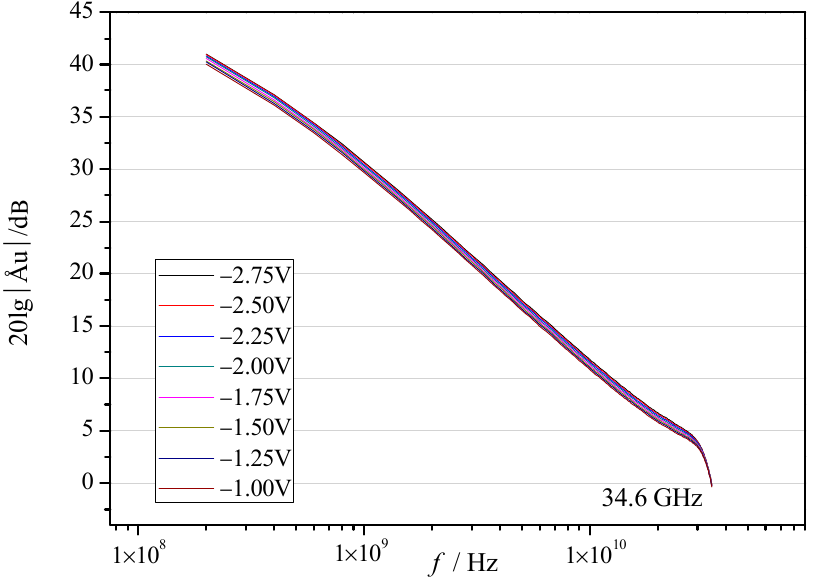
Figure 6. Small signal gain and cut-off frequency characteristics of NDC-GaN HEMTs.